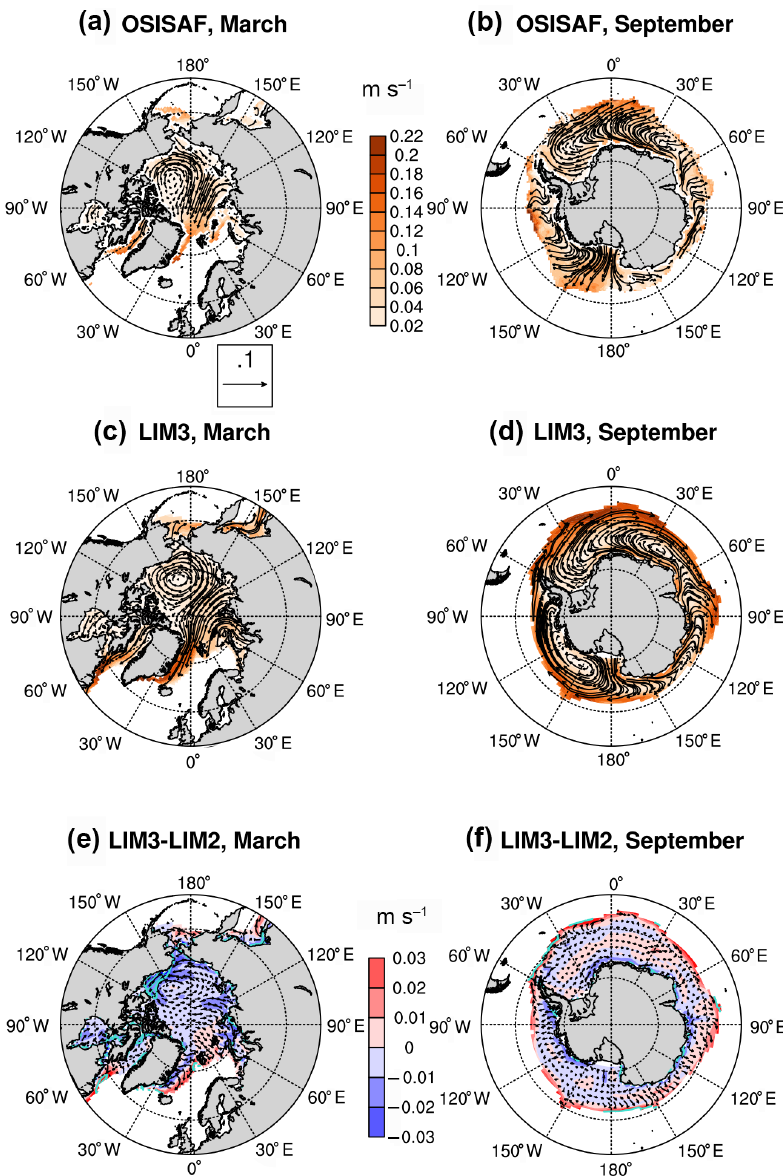
Figure 3. (a) Observed satellite-based average Arctic sea-ice velocity in March (Lavergne et al., 2010) as arrows and the corresponding vector magnitude (speed, ms − 1 ) as filled coloured contours based on years 2009–2015. (b) as (a) , but for the Antarctic in September and based on years 2013–2015. (c) is similar to (a) , and (d) is similar to (b) , but for LIM3 ice velocity and speed based on years 2003–2012. In (e) , mean differences between LIM3 and LIM2 ice velocity and speed are shown in the NH in March, while (f) displays the corresponding differences in the SH in September. In (e) and (f) turquoise hatched regions show areas with statistically significant differences between LIM3 and LIM2 sea-ice speed at the 5% level based on unequal variances t